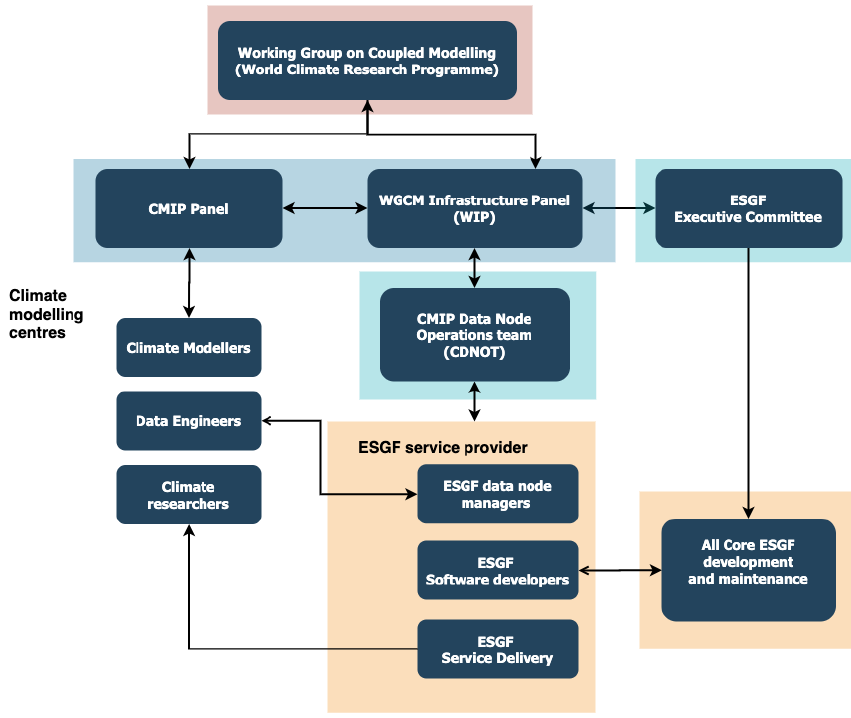
Figure 1. Organogram of the CMIP data delivery management structure.